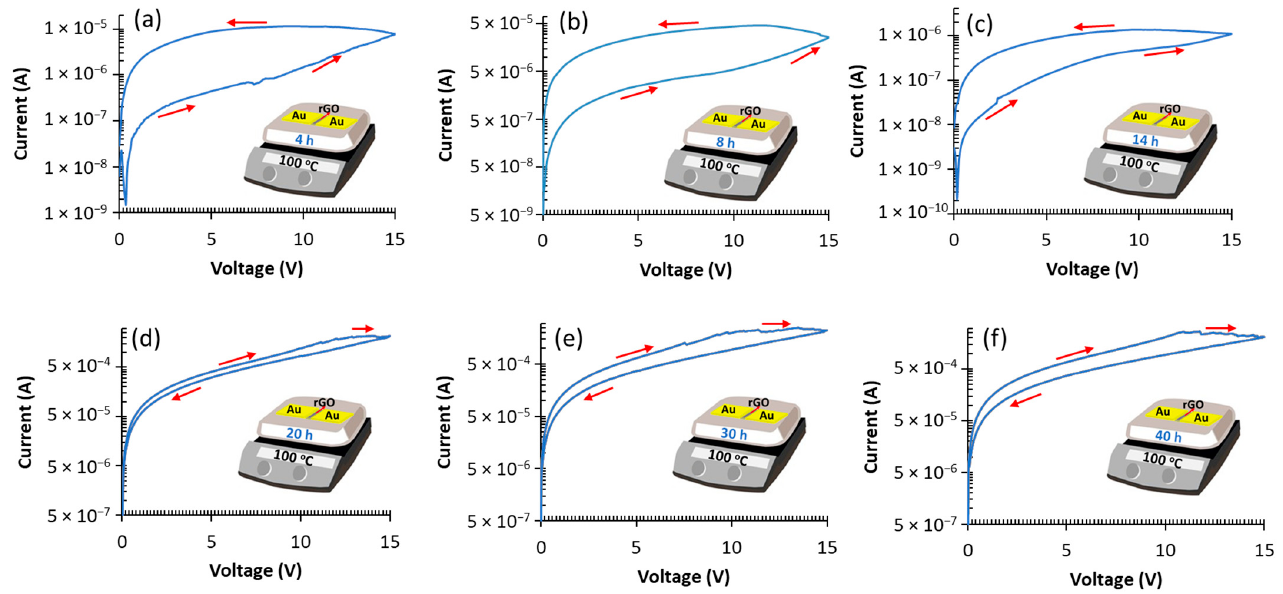
Figure 6. The switching characteristics for devices annealed over six different periods from 4 h to 40 h. ( a – c ) present switching from HRS to LRS, while ( d – f ) show switching from LRS to